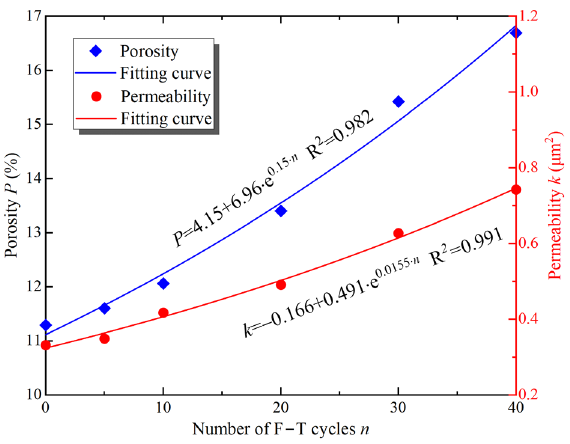
Figure 8. Changes in porosity and permeability of the sample with F–T cycles. Additionally, the pore parameters of the sample, such as pore equivalent diameter and throat length, were determined using the PNM model. The pore diameters were divided into six ranges according to their sizes, i.e., 0–200 µ m, 200–300 µ m, 300–400 µ m, 500–600 µ m, and above 600 µ m, and the results are shown in Figure 9a. After 40 F–T cycles of the sample, the total number of pores increased from 20,832 to 24,160 by about 15.98%, and the number of pores in all ranges showed an increasing trend. According to the distribution of pore diameter values, the minimum increase in the number of pores (<200 µ m) was 12.9%, and the maximum (>600 µ m) was 114.6%. In general, the larger the pore equivalent diameter, the more significant the percentage growth in the number of pores after F–T action. In other words, the larger the pore diameter, the more susceptible it is to F–T action, and the increase in the number of pores implies an increase in F–T weathering damage. Moreover, Figure 9b shows the maximum pore diameter and pore number with the F–T action, and the increase is consistent with the pattern of change in porosity and permeability, i.e., an exponential increase. Compared to the samples without F–T action, the maximum pore diameter of the sample increased from 605 µ m to 856 µ m after 40 F–T cycles, an increase of about 41.4%. The pores also showed an exponential growth pattern, increasing by 12.3% to 23,408 after 30 F–T cycles. The increase in equivalent diameter and pores reflects the increase in pore volume, expressed macroscopically as an increase in porosity in Figure 8. Overall, the increase in the number of pores and the equivalent diameter of the sample caused the expansion and development of microcracks, which in turn caused macroscopic damage to the mechanical properties.